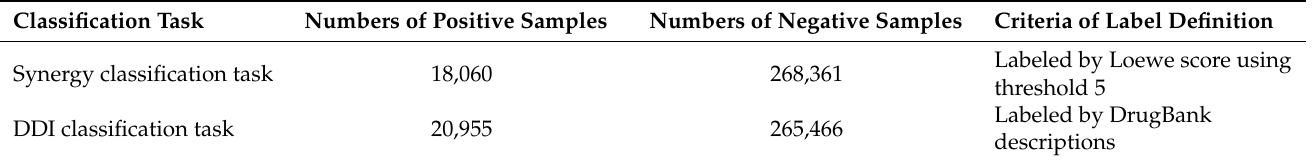
Table 7. Classification label data details.